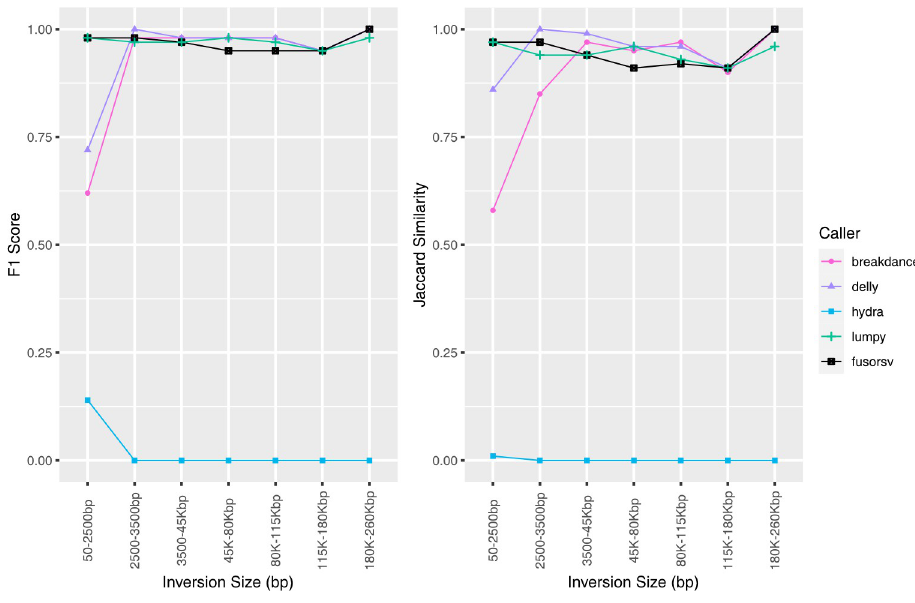
Fig 3. Accuracy of predicted inversions from simulated short-read data. Results shown for 60X depth. https://doi.org/10.1371/journal.pone.0278424.g003 the SVE/FusorSV pipeline can resolve a 3910bp deletion (DEL-1; IV:9,853,675–9,857,585), a